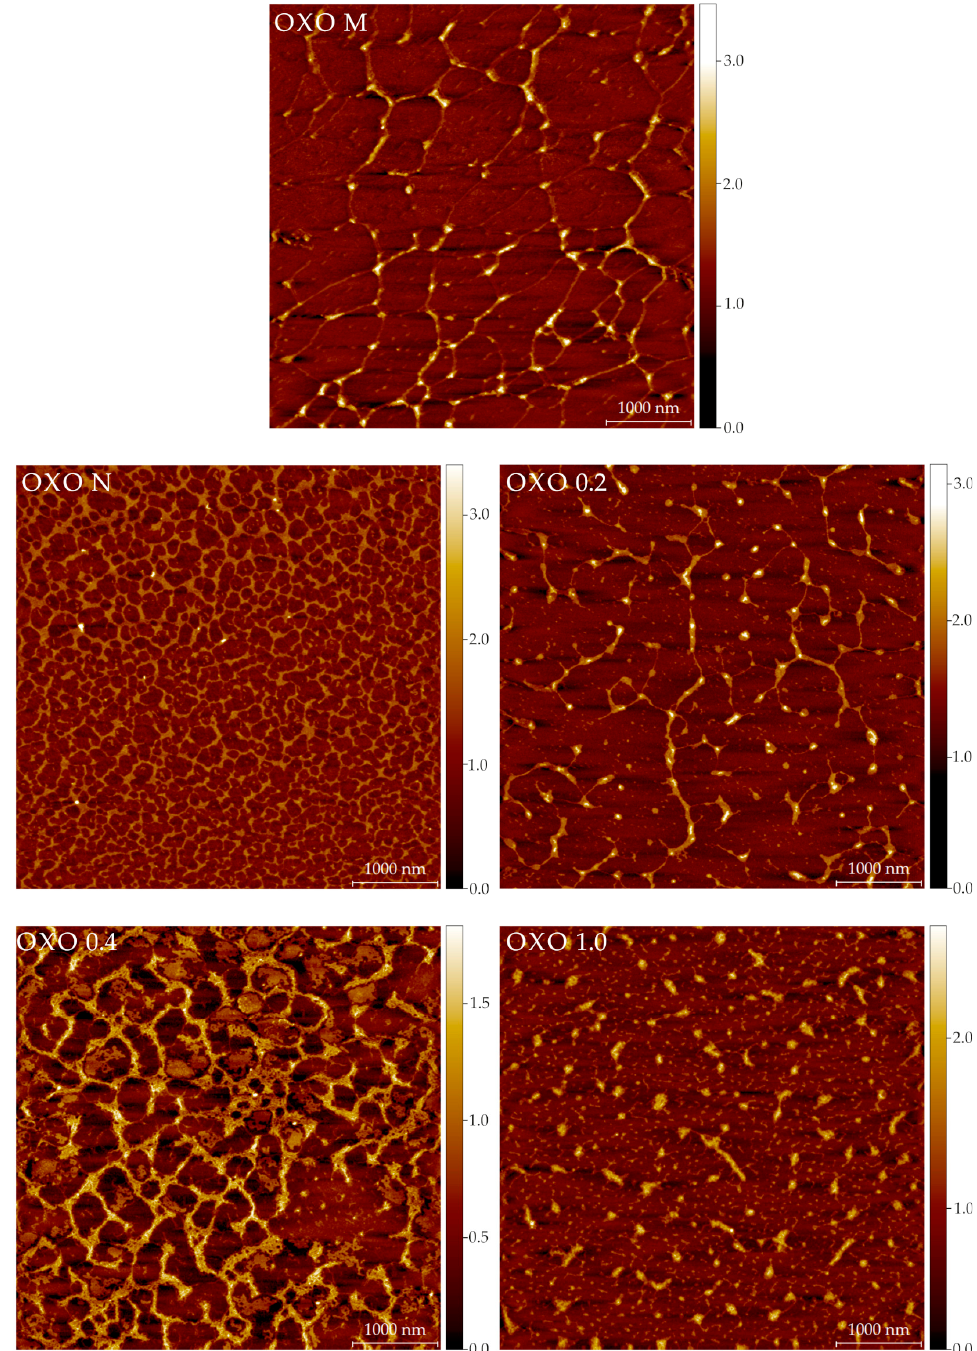
Figure 4. Atomic force microscopy representative images (5 × 5 µ m) of the mucilage extracted from O. joconostle cladodes and its composing polysaccharides. The color scale on the right indicates the height in